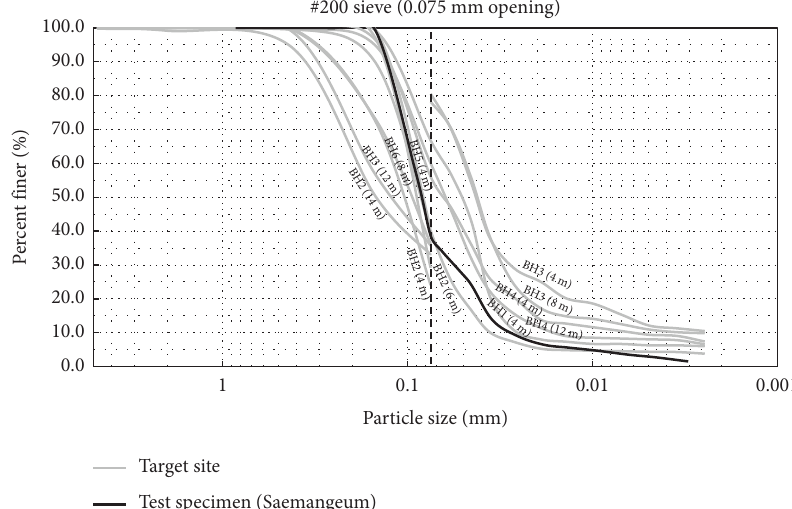
Figure 2: Particle size distribution of samples collected from the target area and Saemangeum landfll site. Table 2: Borehole test results for the target area. Borehole no.